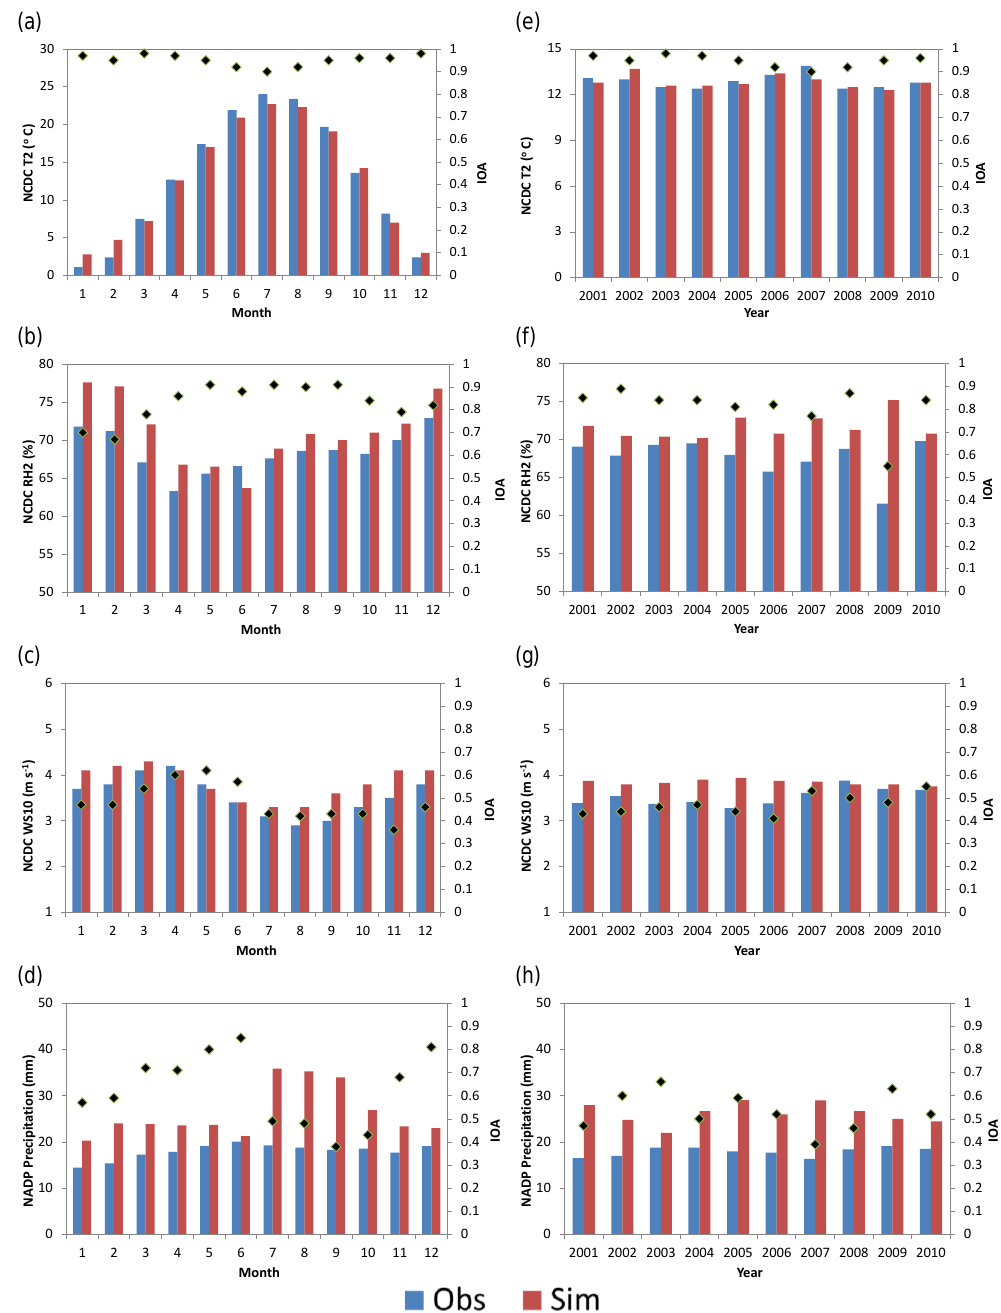
Figure 2. Time series of 10-year averaged monthly observations (blue) vs. simulations (red) for (a) T2, (b) RH2, and (c) WS10 against NCDC data, and (d) precipitation against NADP data, and annual averages for (e) T2, (f) RH2, and (g) WS10 against NCDC data, and (h) precipitation against NADP. IOA statistics (black diamonds) are also provided on the secondary y axes in panels (a) – (h) .